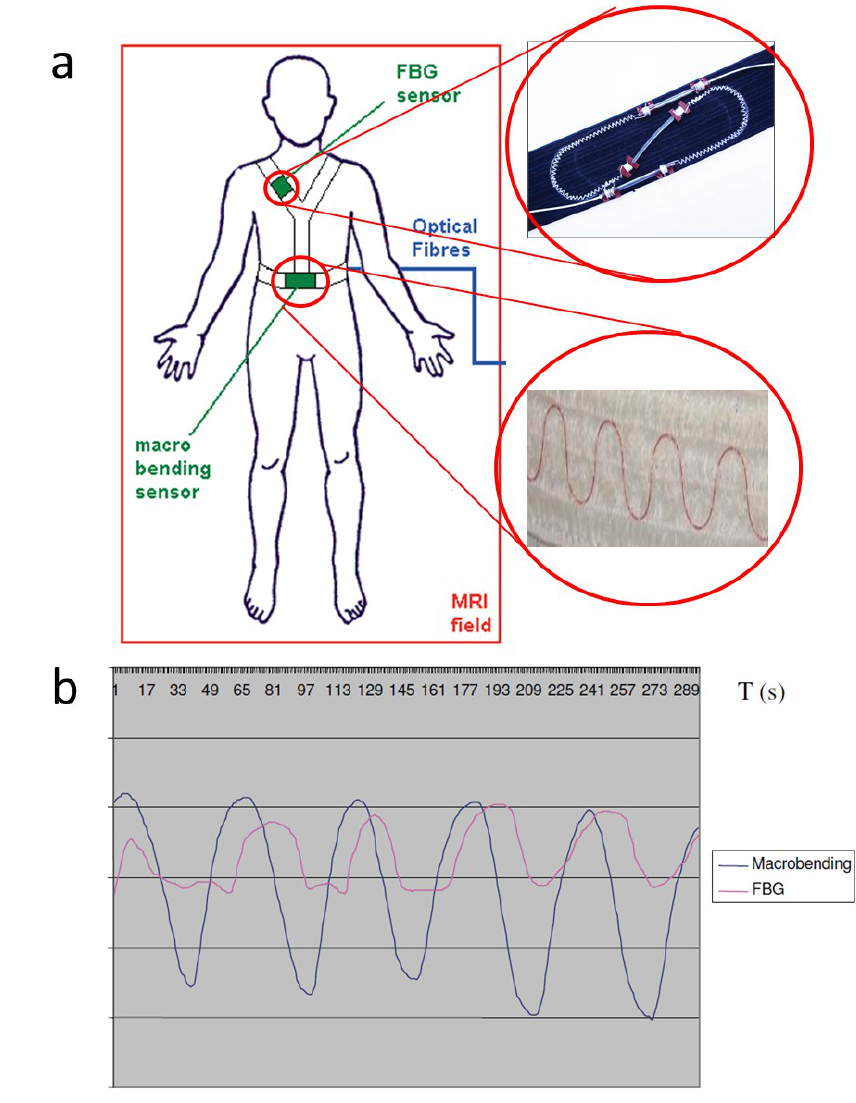
Figure 11. ( a ) The optical fibers-textile integration, illustrating the optimal positions of macro-bending and FBG sensors. ( b ) The signals of both the abdominal and thoracic movements using both types of sensors